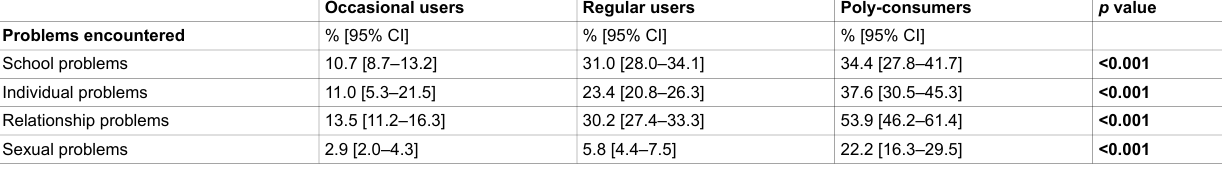
Table 2: Bivariate analysis of substance-related problems according to IPS consumption profile.